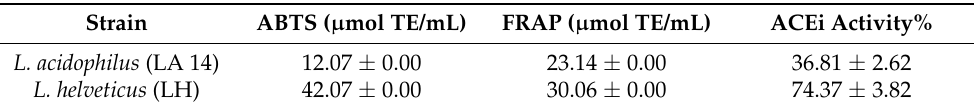
Table 1. Comparison of the antioxidant (by ABTS and FRAP assays) and ACEi activities of hy- drolysates after 12 h fermentation with L. acidophilus and L. helveticus . Values are expressed as mean values ± standard deviation (SD), n =